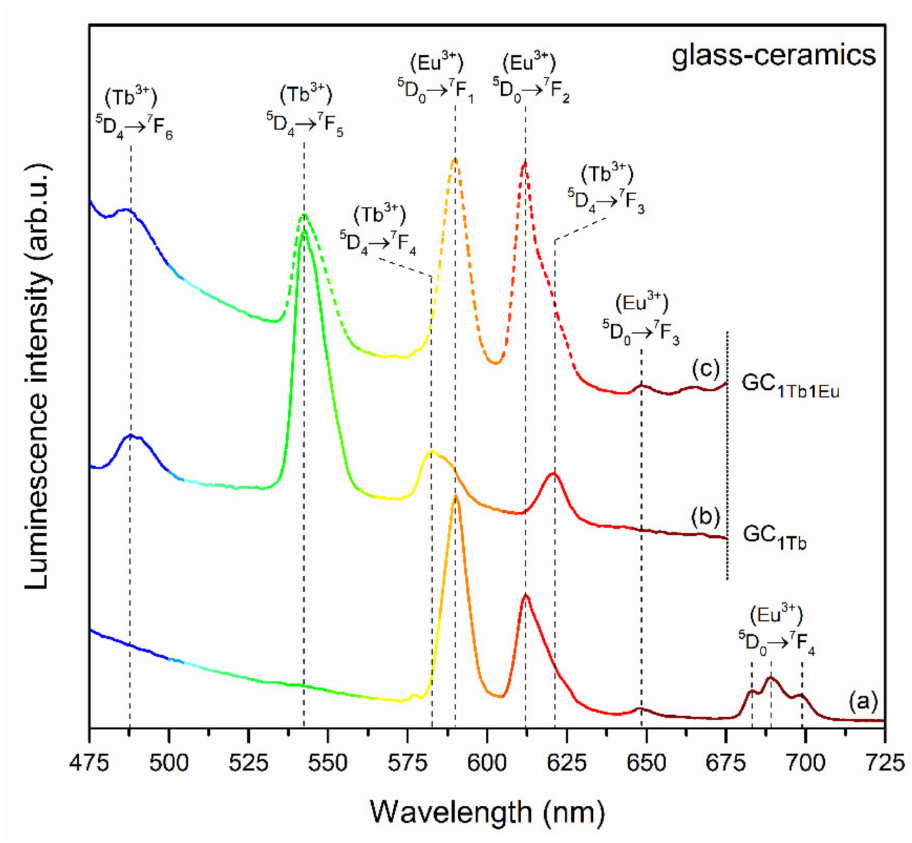
Figure 9. Emission spectra of: ( a ) GC 1Tb1Eu ( λ exc = 395 nm), ( b ) GC 1Tb ( λ exc = 351 nm), and ( c ) GC 1Tb1Eu ( λ exc = 351